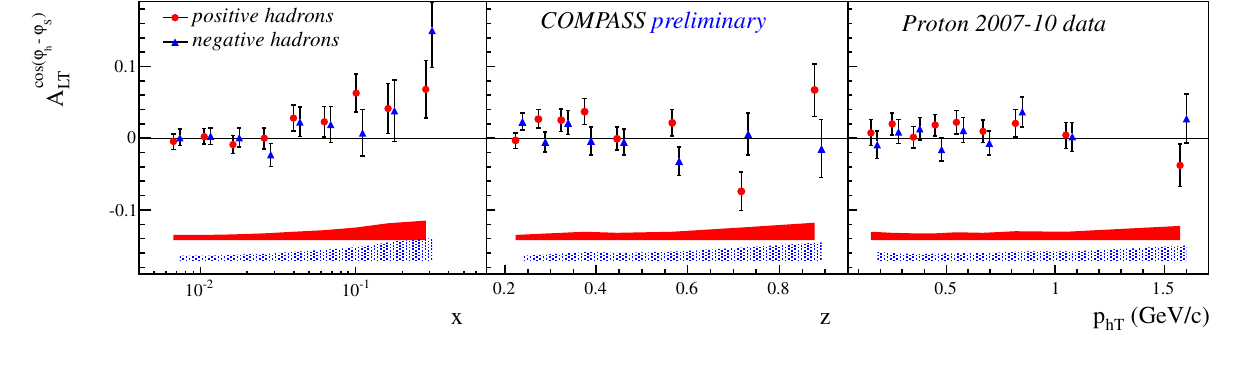
Figure 13. COMPASS measurement of A cos( φ h − φ s )